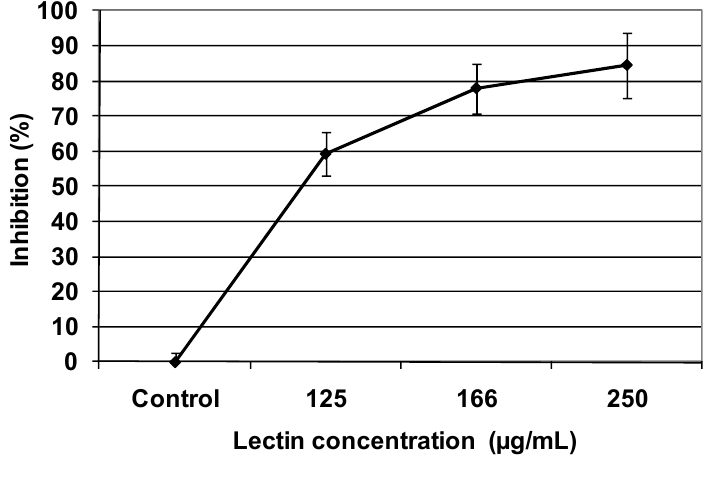
Figure 4 . Inhibitory effect of tepary bean lectin on colony formation of the human epithelial cervical carcinoma cell line (C33-A). Cells were exposed to the indicated concentration of lectin for 1 h, then the number of cells that were able to form colonies was determined as described in the Experimental section. Results are presented as the percentage of the inhibition of colony formation. Each value represents the mean (± SD) obtained from triplicate